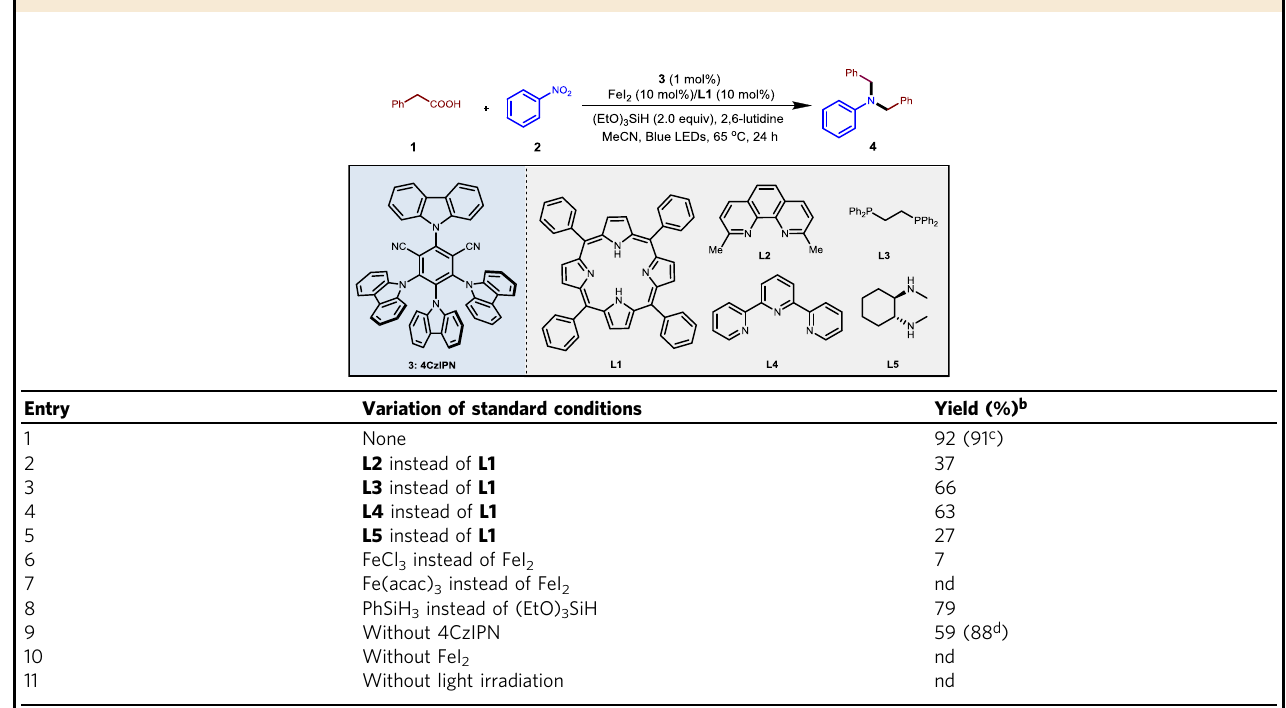
Table 1 Optimization of catalytic amination conditions a